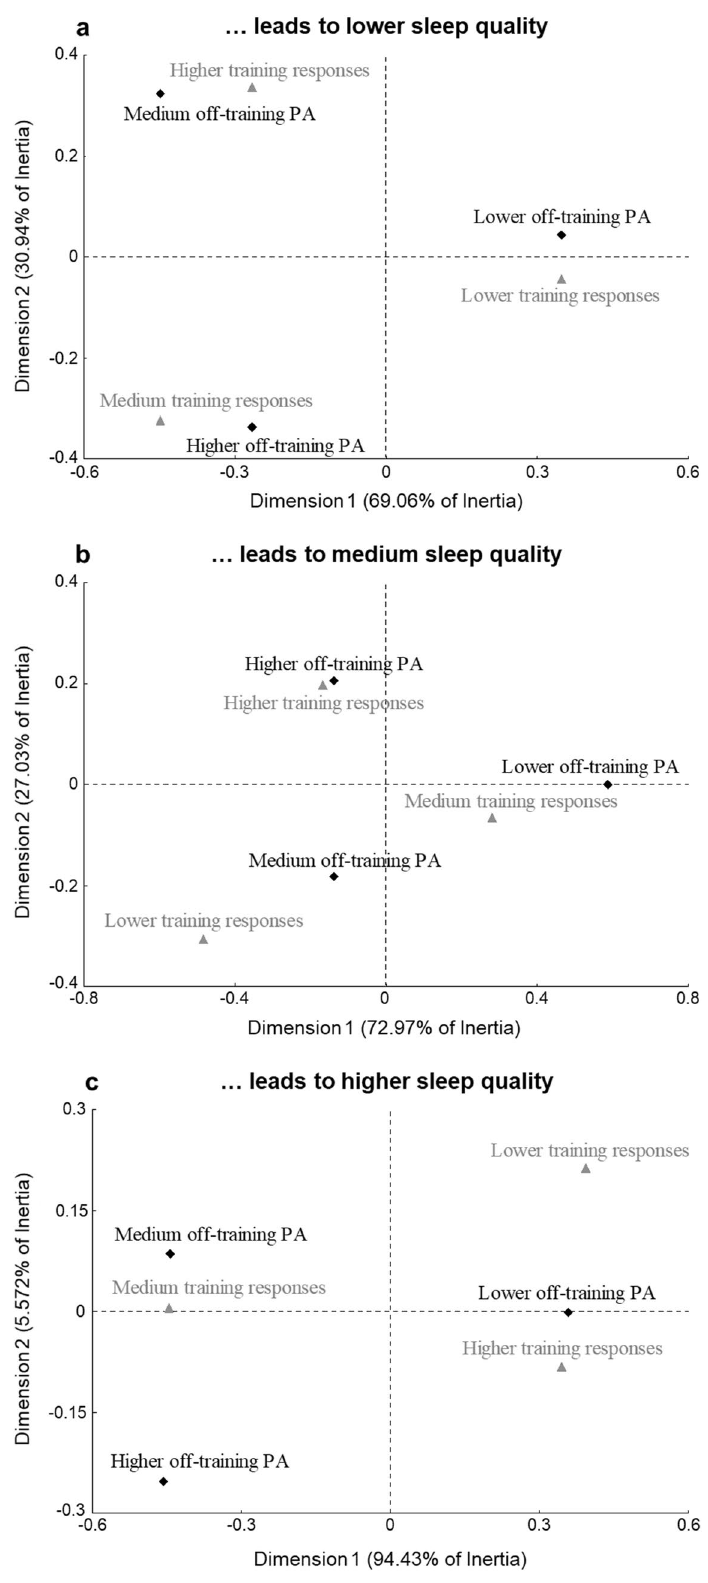
Figure 2. ( a – c ) Bi-plot from the correspondence analysis of off-training PA and training responses, according to sleep quality. ( a ) Leads to lower sleep quality; ( b ) leads to medium sleep quality; ( c ) leads to higher sleep quality. PA physical